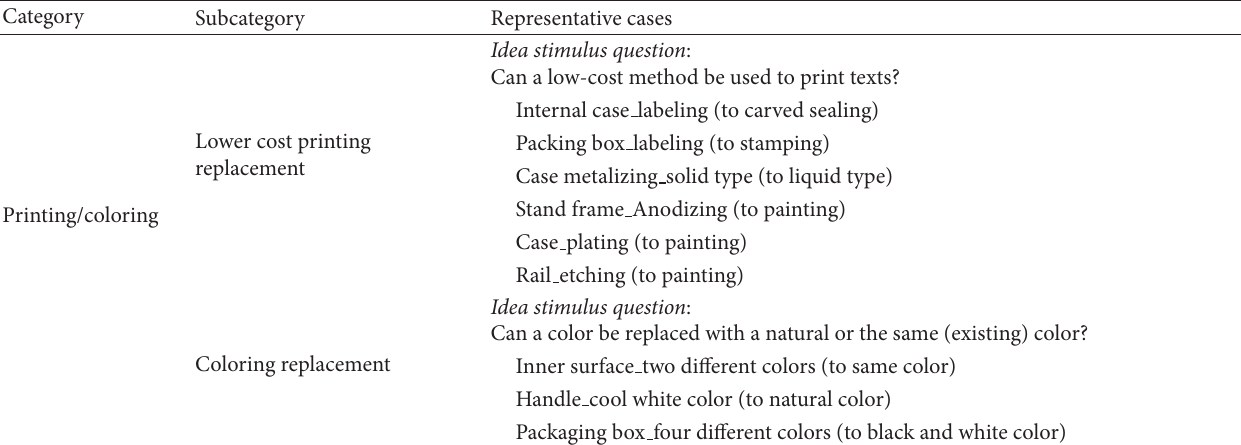
Table 6: Printing/coloring checklist and representative